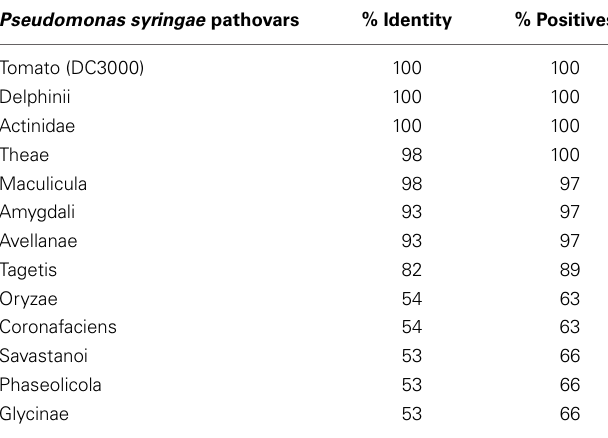
Table 2 | Sequence conservation of HrpA1 N-terminal sequence among Pseudomonas syringae